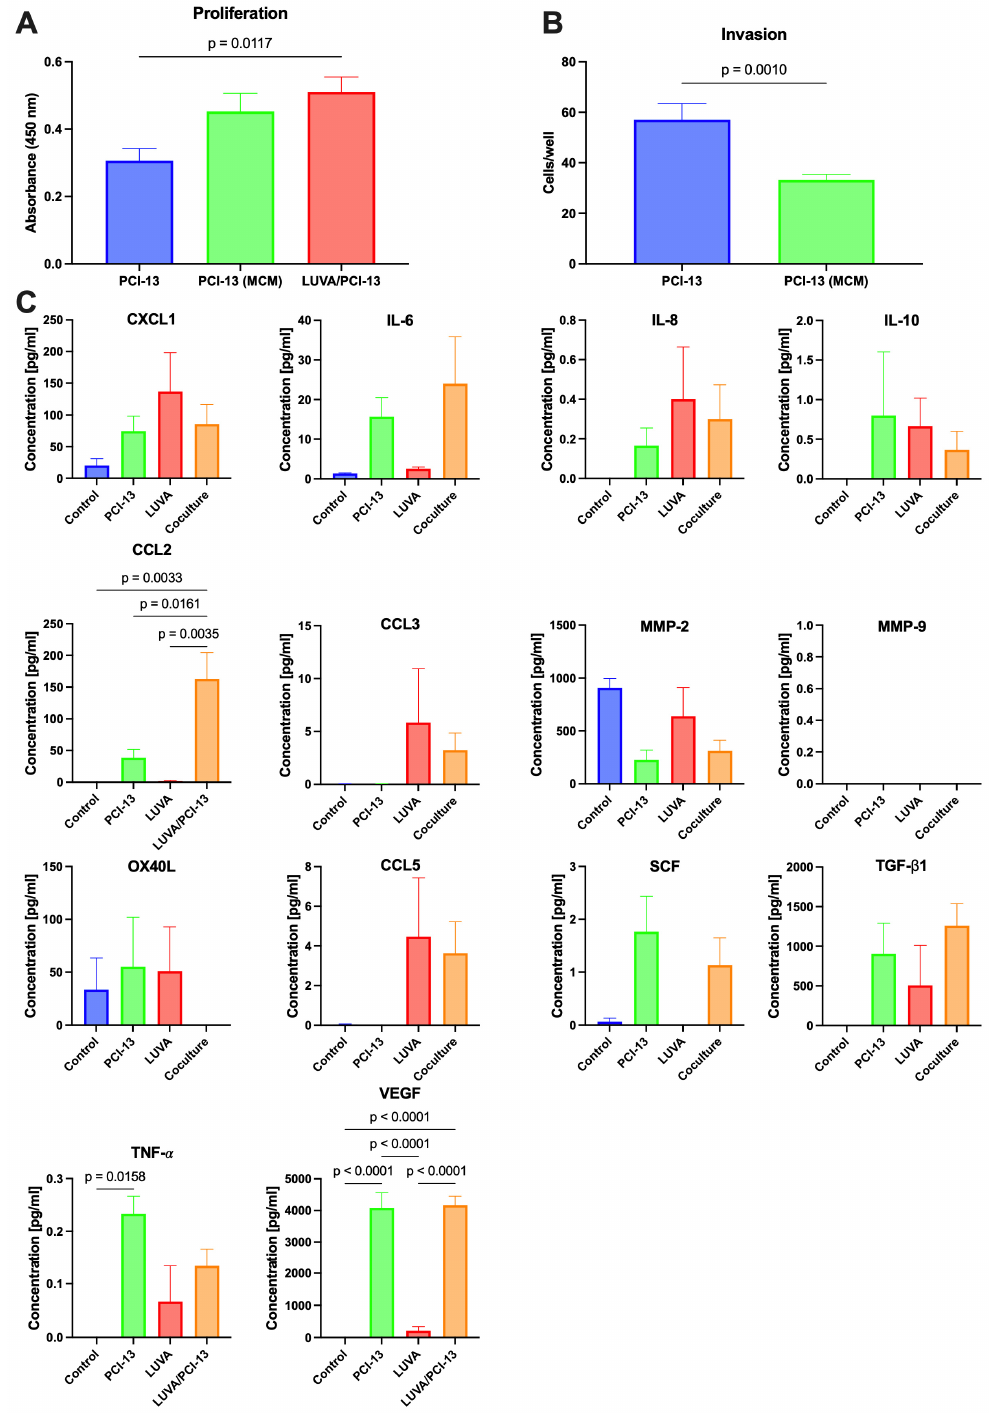
Figure 1. In vitro analysis of MC/OSCC interactions: ( A ) Influence on OSCC cell proliferation. PCI-13 cells cultured in unconditioned medium (PCI-13), PCI-13 cultured in MC-conditioned medium (MCM), and LUVA/PCI-13 co-cultures, based on 5 × 10 3 OSCC cells, respectively. ( B ) Influence on OSCC cell invasion. PCI-13 cells cultured in unconditioned medium (PCI-13) and PCI-13 cells cultured in MCM. ( C ) Multiplex ELISA analysis of known MC/tumor cell interaction partners: CXCL1, IL-6, IL-8, IL-10, CCL2, CCL3, MMP-2, MMP-9, OX40L, CCL5, SCF, TGF- β 1, TNF- α , and VEGF. Cell medium alone as control (control), PCI-13 conditioned medium (PCI-13), LUVA conditioned medium (LUVA), and medium from LUVA/PCI-13 co-cultures (LUVA/OCI-13).